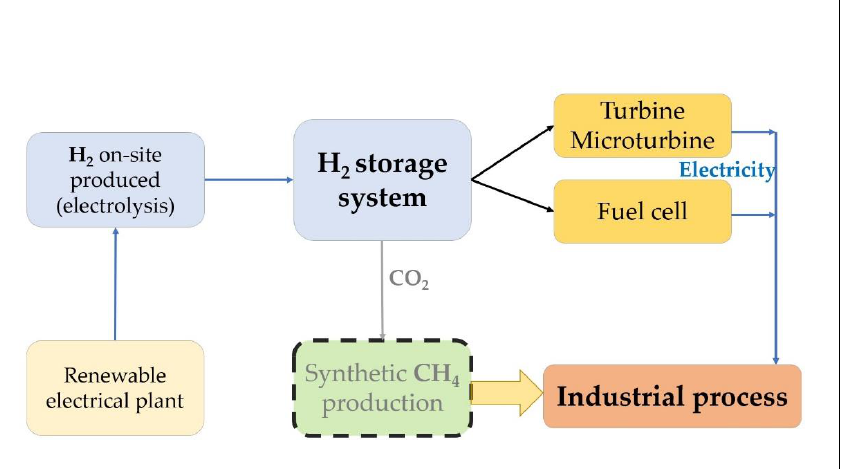
Figure 2. Power to Power (PtP) system and possible integration of Combined Heat and Power.